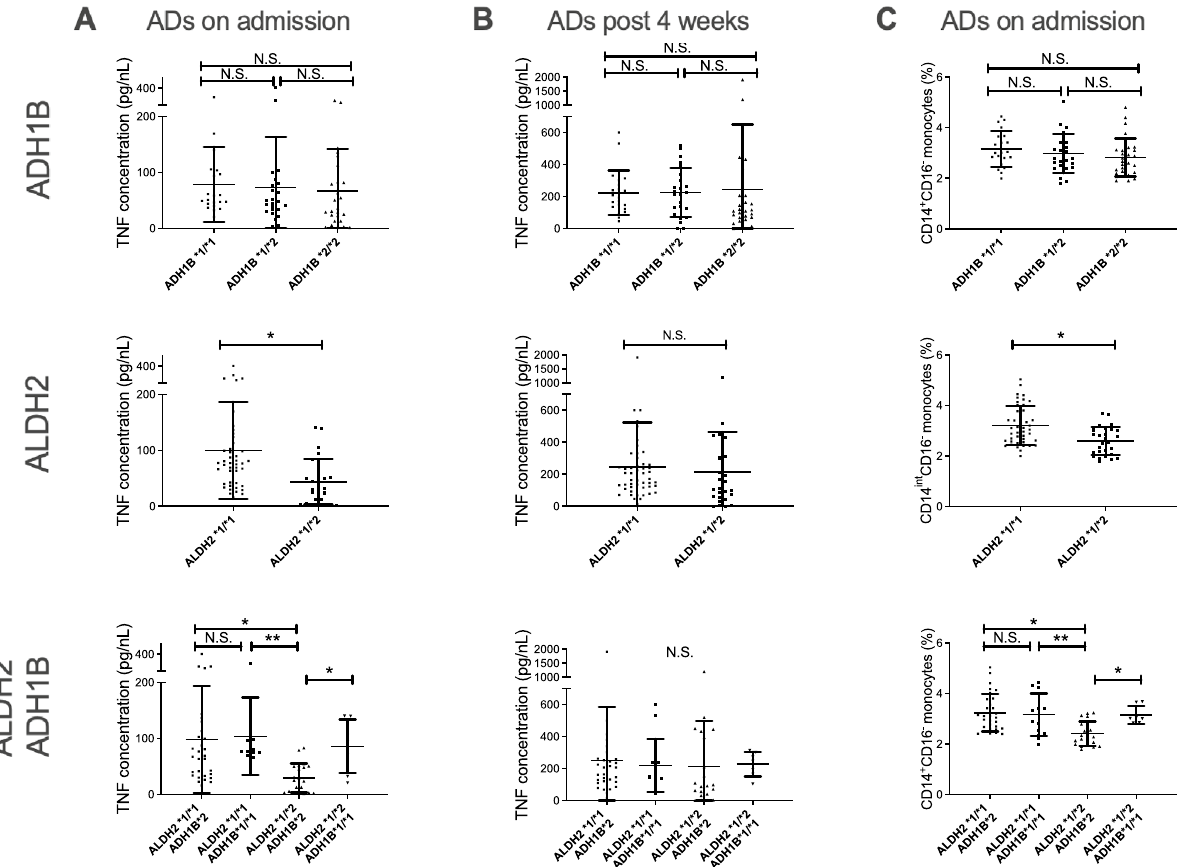
Figure 3. CD14 + CD16 − monocytes in alcohol-dependent (AD) patients with ADH1B*2 and ALDH2*1/*2 genotypes demonstrate a deeply suppressed phenotype. ( A – C ) Concentration of TNF-α in the culture supernatants of CD14 + monocytes isolated from AD patients on admission ( A ) and at 4 weeks post-abstinence ( B ) according to the genetic polymorphism of ADH1B (upper), ALDH2 (middle), and the combination (lower). ( C ) Frequency of CD14 + CD16 − monocytes isolated from AD patients on admission according to the genetic polymorphism in ADH1B (upper), ALDH2 (middle), and the combination (lower). Data represent the mean ± SD. * p < 0.05 by Student’s paired t-test for two groups or by one-way ANOVA for three or four groups. N.S.: not